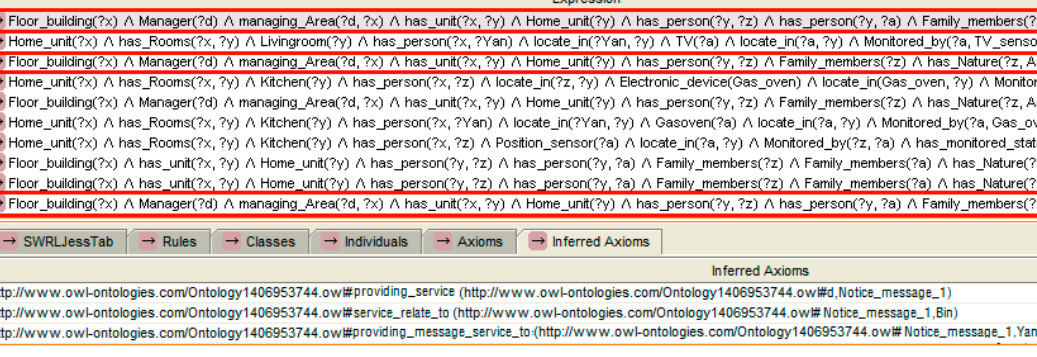
Figure 21. The rule selected and the reasoning result of the message service.